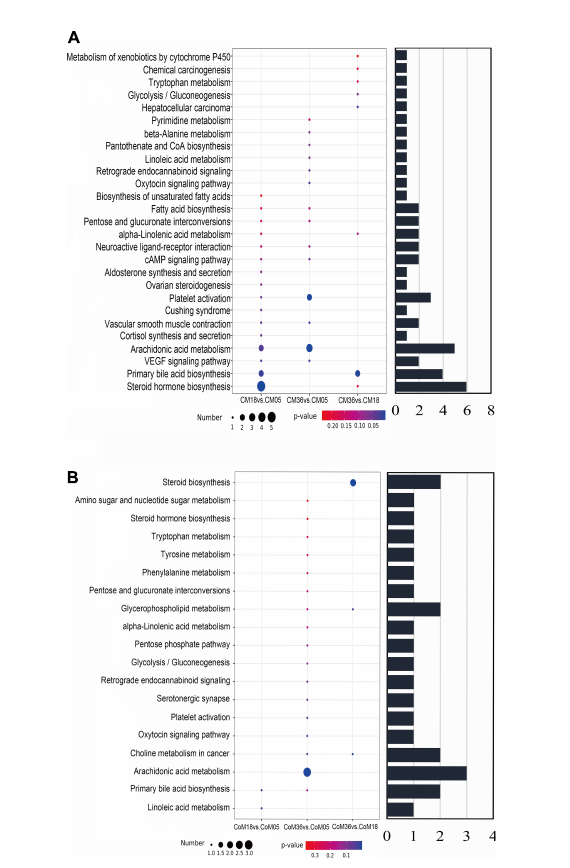
FIGURE6 The bubble diagrams show differential metabolites in cecum (A) and colon (B) to be enriched in the pathways by KEGG analysis. The diameter of the circle shows the number of differential metabolites enriched in this pathway and the bar chart shows the total